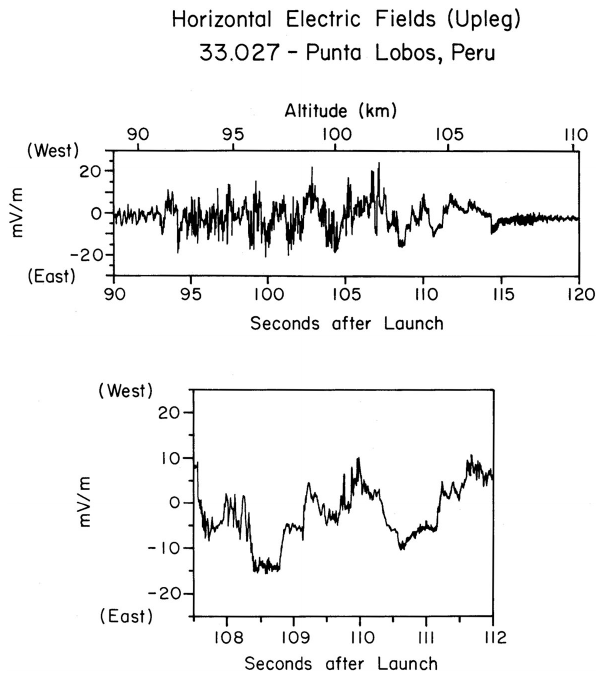
Fig. 6. Daytime (10:34LT on 12 March 1983) rocket observations of horizontal electric fields over Peru due to large scale waves. Note that the magnitudes are comparable to typical strong vertical polar- ization fields and are much larger than the eastward S q field (from Pfaff et al., 1987a).